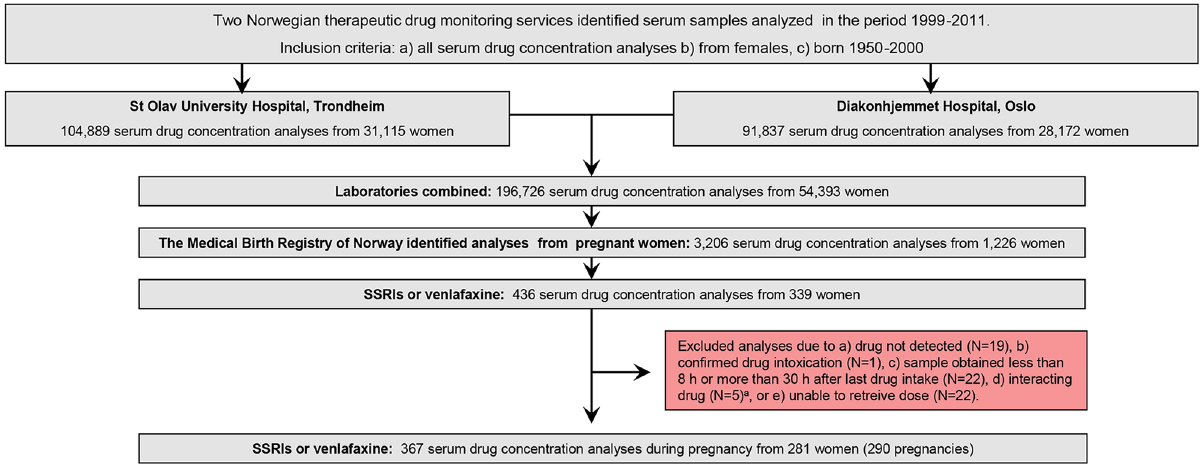
Fig 1. Inclusion flow chart. Sample identification and inclusion of therapeutic drug monitoring samples of selective serotonin reuptake inhibitors and venlafaxine obtained during pregnancy. a Five analyses were excluded due to the following drug interactions: sertraline + carbamazepine (n = 1), venlafaxine + bupropion (n =